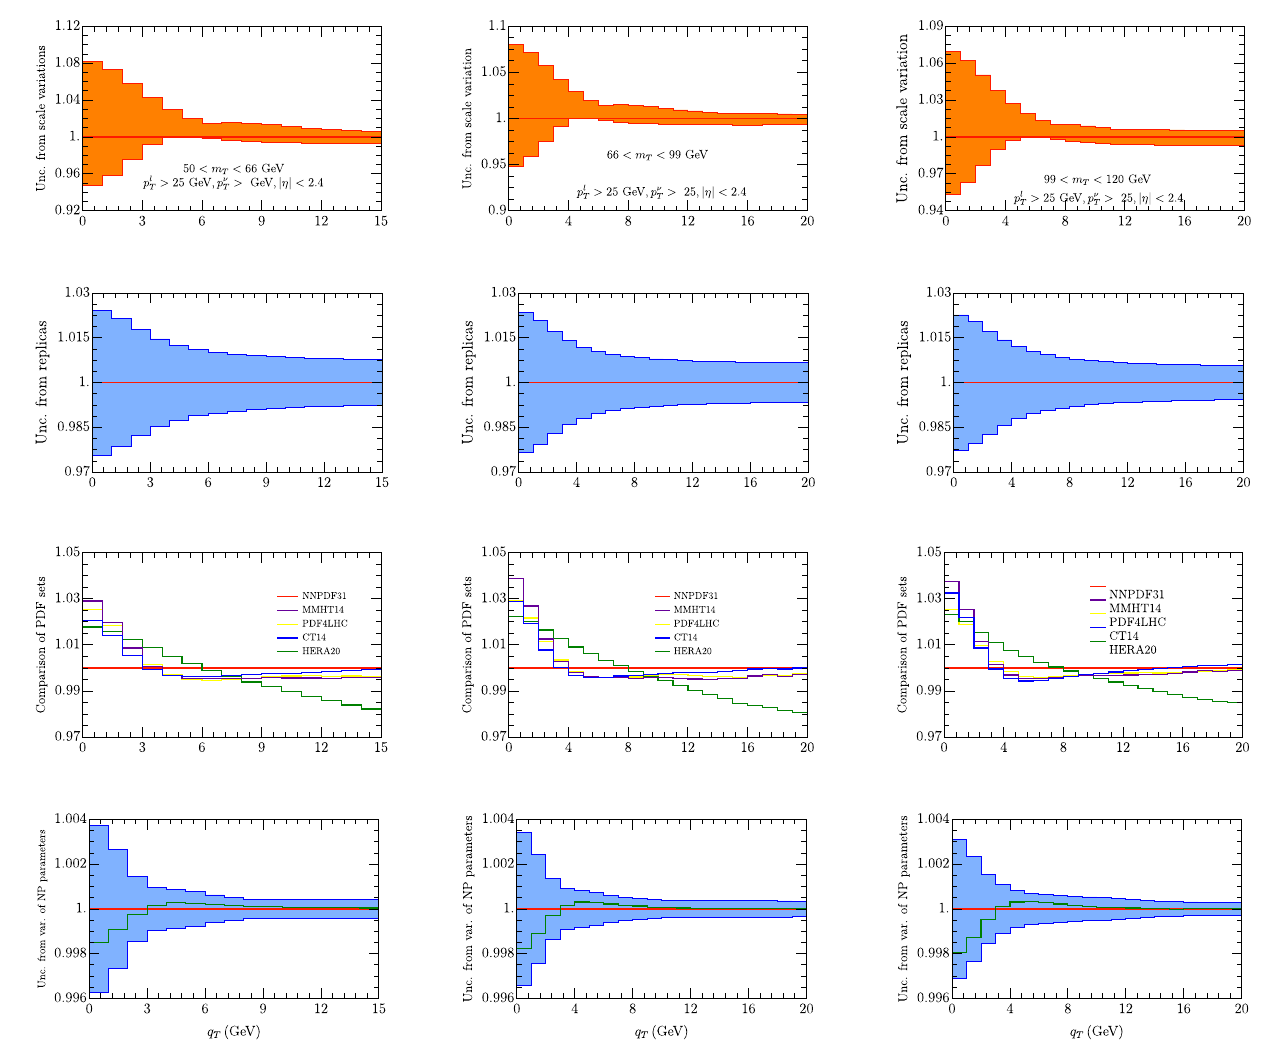
> 25 GeV, | η | < 2 . 4 Fig. 3 Error for W + cross section for p l ,ν of the cross section given by the central replica is represented by the l T green line. On the third line we represent the value of each been with and the m T intervals [ 50 , 66 ] GeV (left column), [ 66 , 99 ] GeV (middle different sets of PDF. On the fourth row we have the uncertainty due column), [ 99 , 120 ] GeV (right column). In the first line we report the to non-perturbative parameters. The central value is given by the the theoretical error from scale uncertainties as explained in the text. In central replica of NNPDF31_nnlo_as_0118 [28]. The cross section for the second line we have the error calculated as a variance in each bin the central replica is shown in Fig. of 100 replicas of the set NNPDF31_nnlo_as_0118 [28]. The uncer- tainty is referred to the average value of each bin (red line). The value